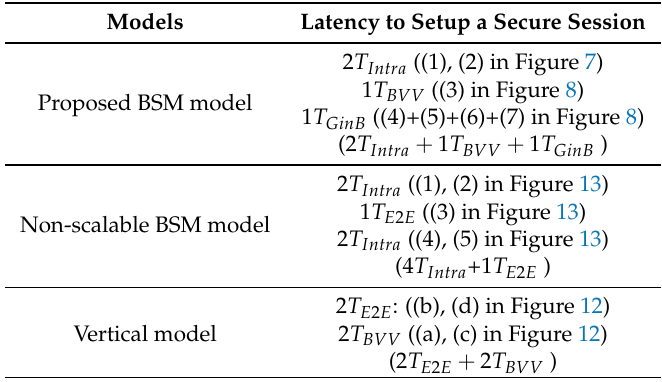
Table 1. Comparisons on latency needed to set up packet key-based session.